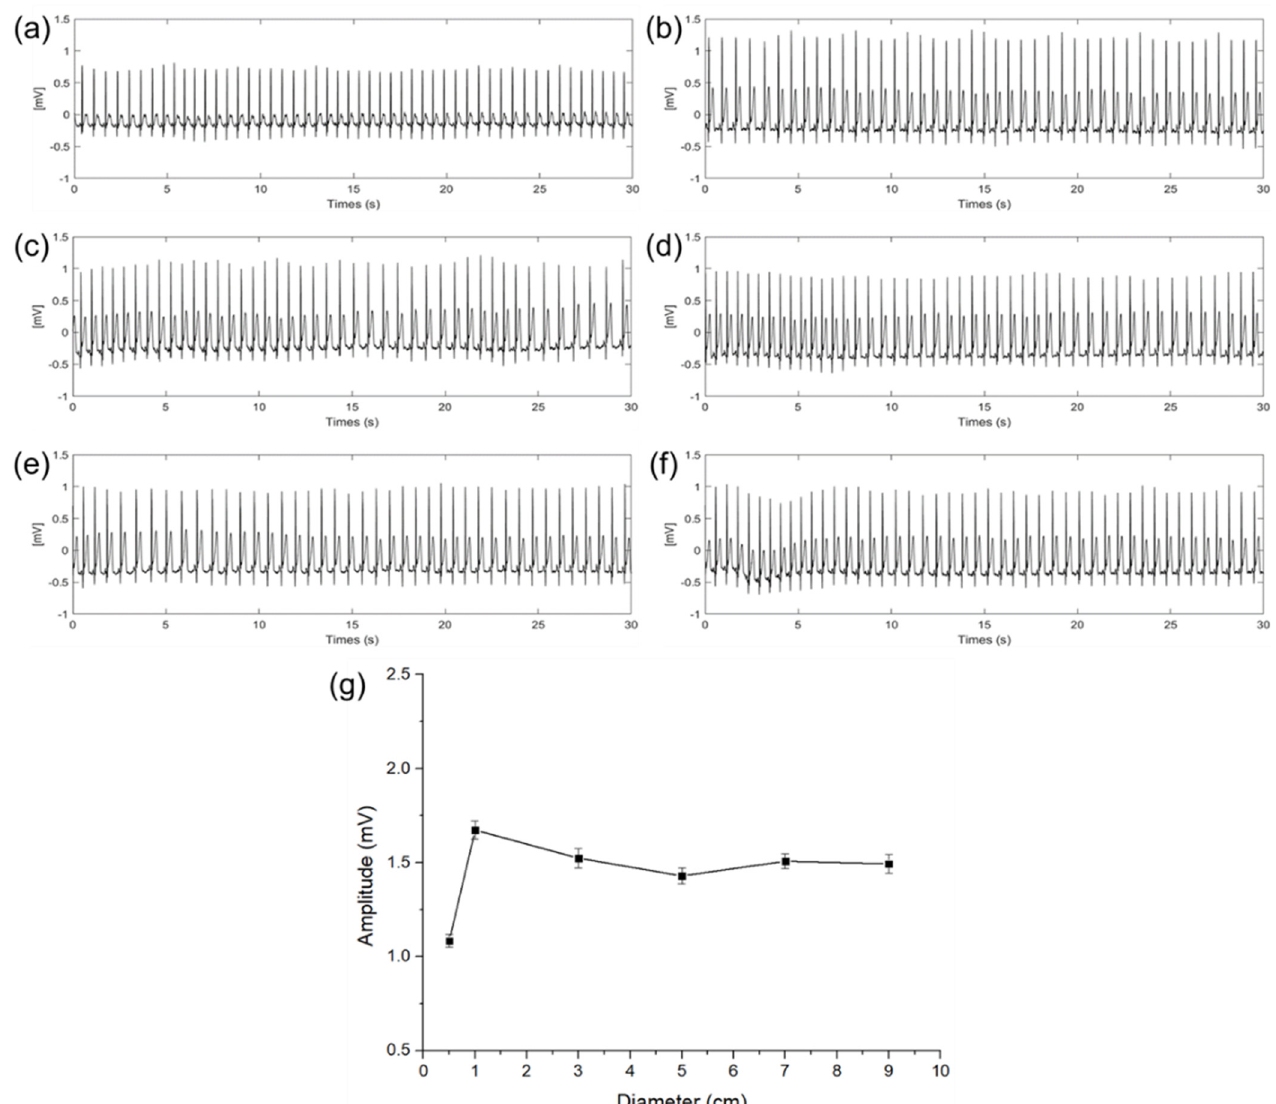
Figure 6. ECG signals of electrode diameter with ( a ) 0.5 cm, ( b ) 1 cm, ( c ) 3 cm, ( d ) 5 cm, ( e ) 7 cm, ( f ) 9 cm, and ( g ) QRS complex amplitude and standard deviation comparison according to the diameter of electrodes.